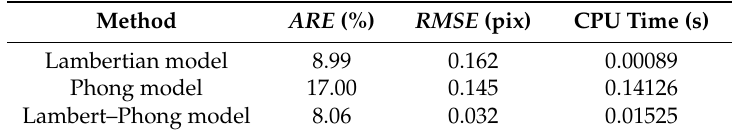
Figure 7. ( a ) Real profile of the droplet; ( b-1 ) 3D shape reconstruction of the real image using the Lambertian model algorithm; (b-2 ) 3D shape of the real image and the side cross section contrast diagram using the Lambertian model algorithm; ( c-1 ) 3D shape reconstruction of the real image using the Phong hybrid model algorithm; ( c-2 ) 3D shape of the real image and the side cross section contrast diagram using the Phong hybrid model algorithm; ( d-1 ) 3D shape reconstruction of the real image using the Lambert–Phong model algorithm; ( d-2 ) 3D shape of the real image and the side cross section contrast diagram using the Lambert–Phong model algorithm. Table 2. Comparison of height average relative error, height root mean square error, and operational speed of three algorithms for the real image.